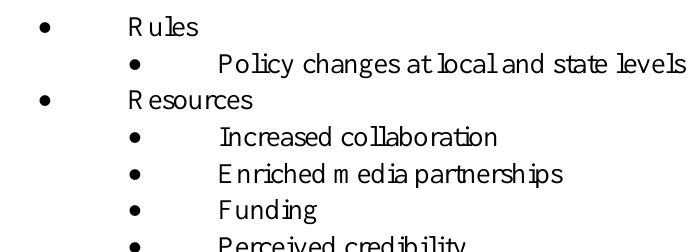
Table 2 Dialogic Transformation at the Public